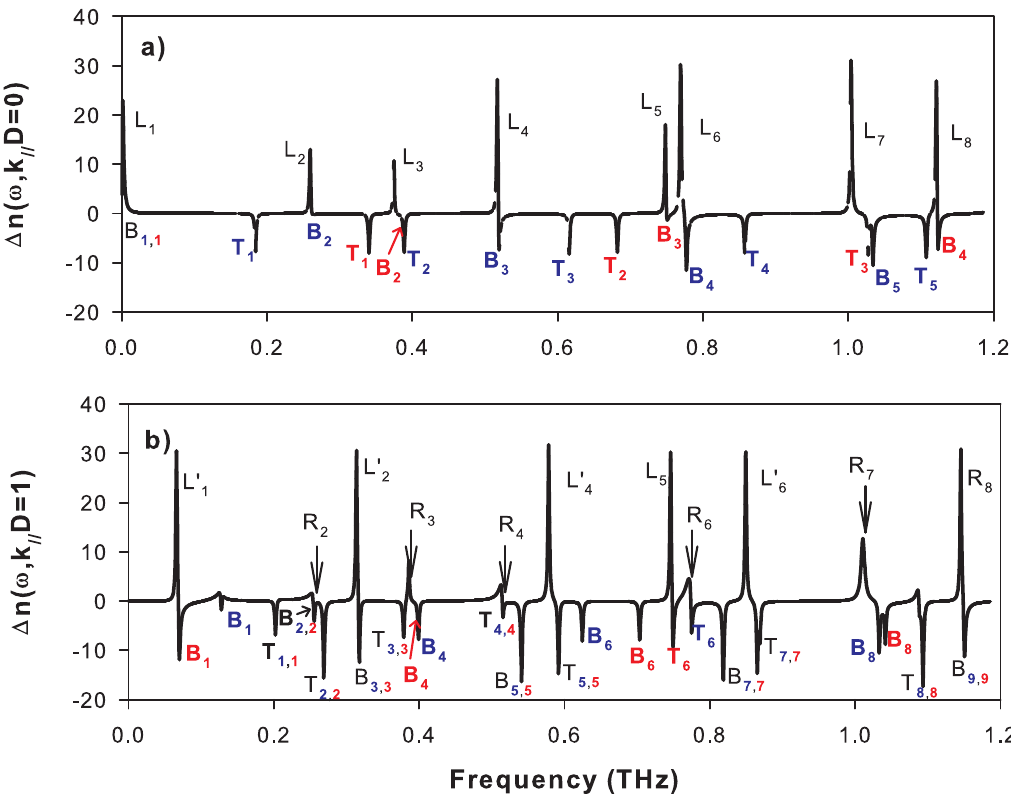
Figure 4. Variation of the density of states between the semi-infinite SL terminated by a graphene layer of thickness d G = 0.335 nm and the same volume of an infinite SL (Equations (23) and (24)) versus the frequency (in THz), for k // D = 0 ( a ) and k // D = 1 ( b ). L i and R i refer to localized and resonant modes, respectively. B i and T i indicate the bottom and top of the two types of